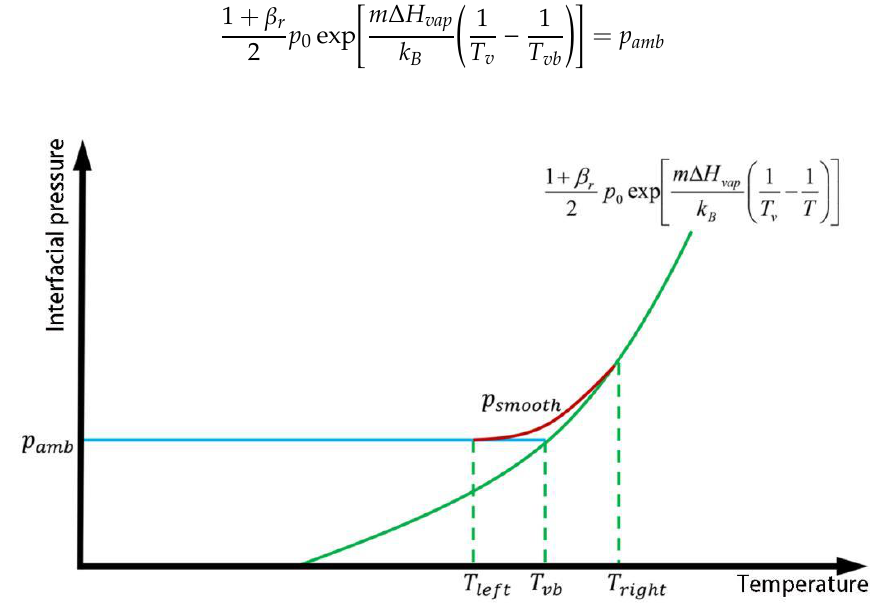
Figure 2. Schematic of the vaporization pressure model.